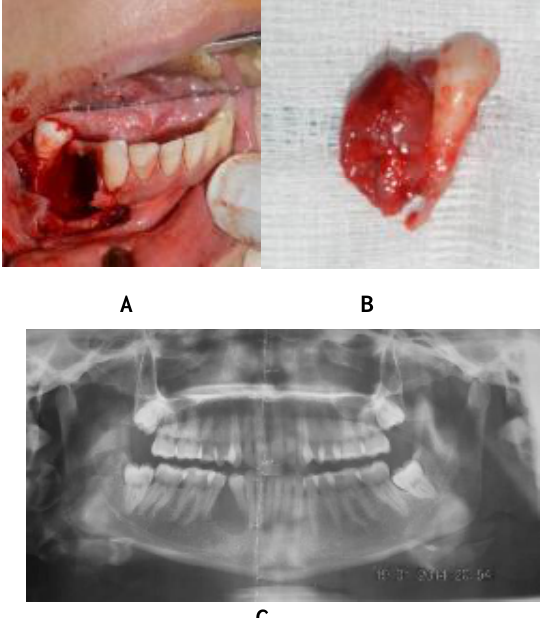
Figure1: Extirpated tumor completely encased the tooth (A). The cyst bag adhered laterally to the lower first premolar’s root (B). Panoramic radiograph before therapy. A well-demarcated unicystic radiolucent lesion in the lower right side jaw between the roots of the teeth 44 and 45 results in root divergence, and adjacent tooth 44 showed resorption of the root